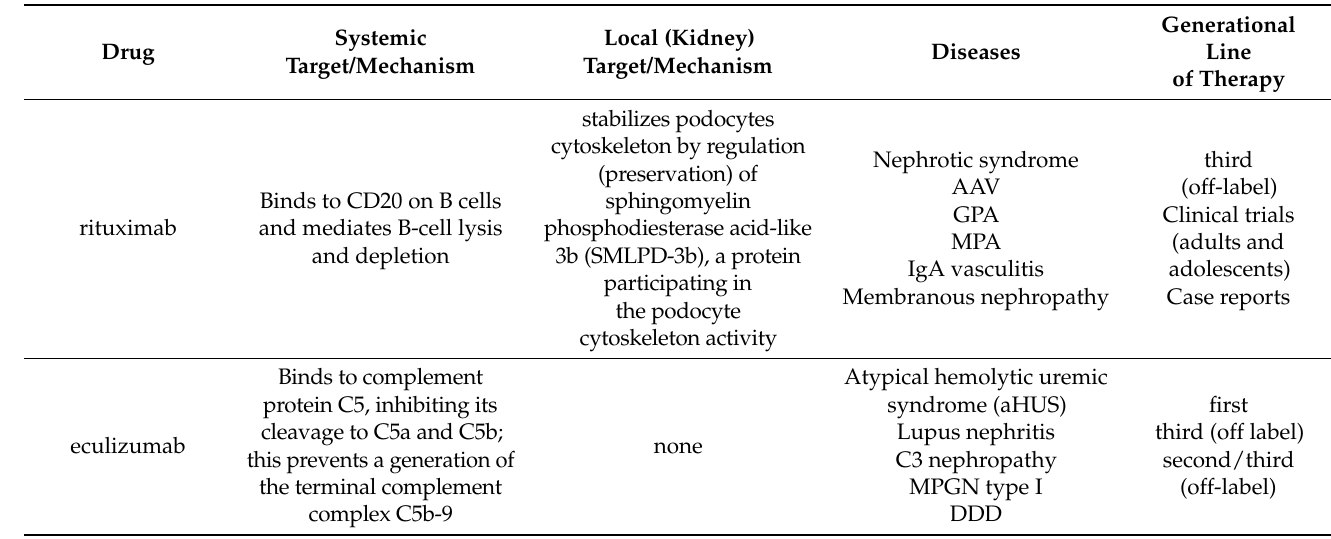
Table 2. Summary characteristics of the biologic drugs used in pediatric immune-mediated